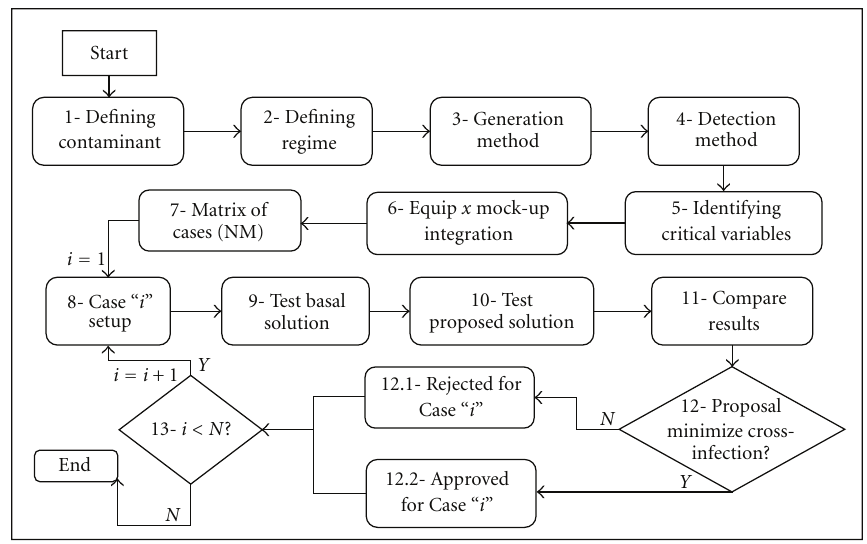
Figure 14: Method to evaluate the response of air distribution solutions for indoor air